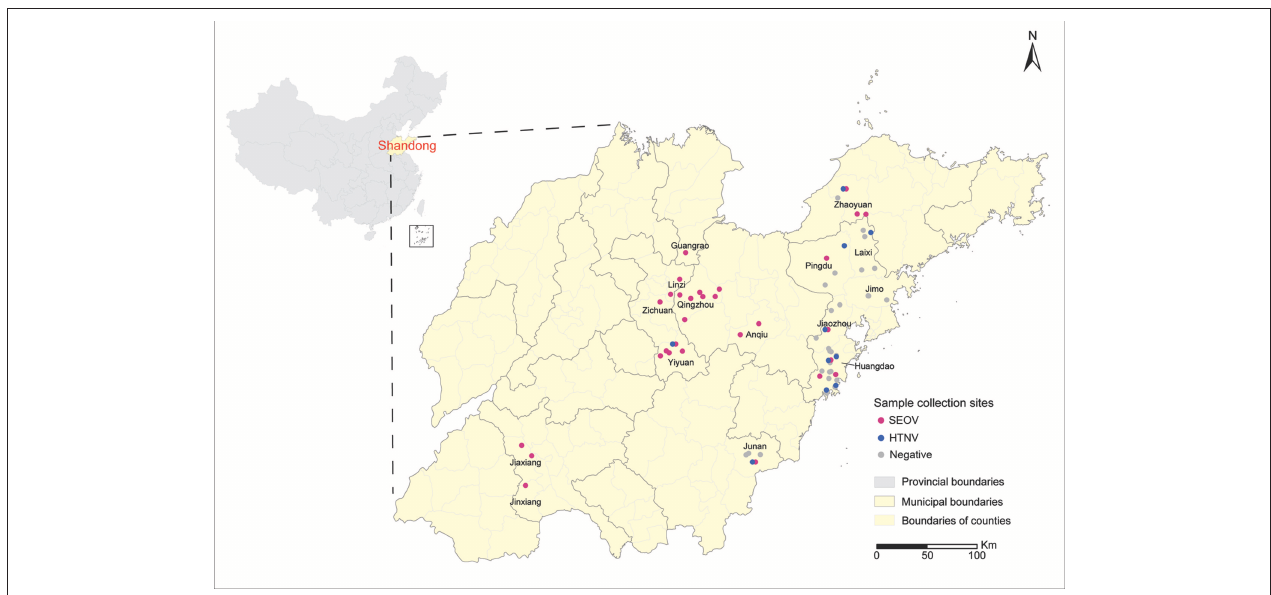
FIGURE 1 | Sample collection sites. Sample collection sites are represented by dots colored according to the disease etiology (red, Seoul virus; blue, Hantaan virus; gray, negative). Map was obtained from the Chinese Academy of Surveying & Mapping. Geographic coordinates of each sample collection site were obtained using the Baidu Coordinates Pick-up System, and were indicated on the map using the ArcGIS 10.2